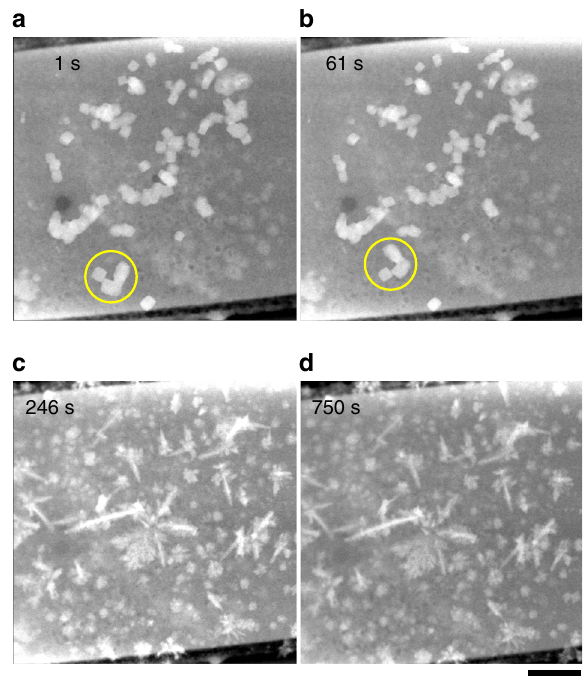
Fig. 5 Evolution of Cu 2 O cubes during reducing conditions. STEM images of the working electrode at different experimental times, a t = 1 s, b t = 61 s, c t = 246 s, and d t = 750 s, acquired while keeping the potential at − 0.7 V in a CO 2 -saturated 0.1 M KHCO 3 solution. It can also be seen that many cubes have started to reduce in size. A cluster of cubic particles that moved between t = 1 s and t = 61 s is highlighted with a yellow circle. After t = 245 s, no further changes in the nanostructure morphology were apparent. The scale bar corresponds to 1 µ